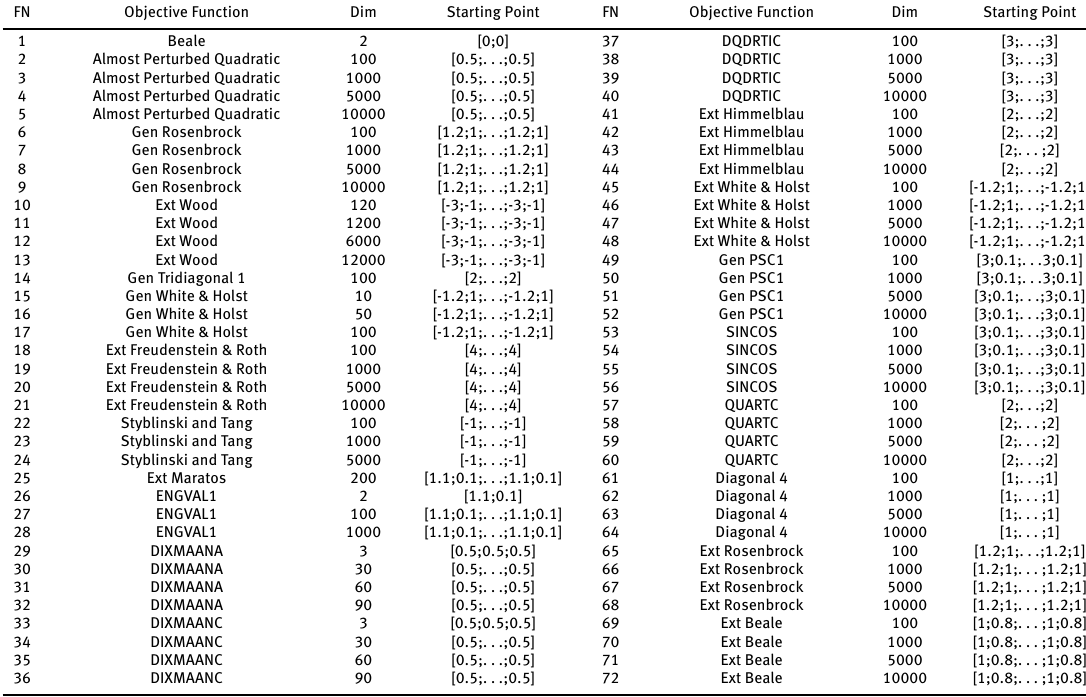
Table 1: Table of test functions, dimensions and starting points.